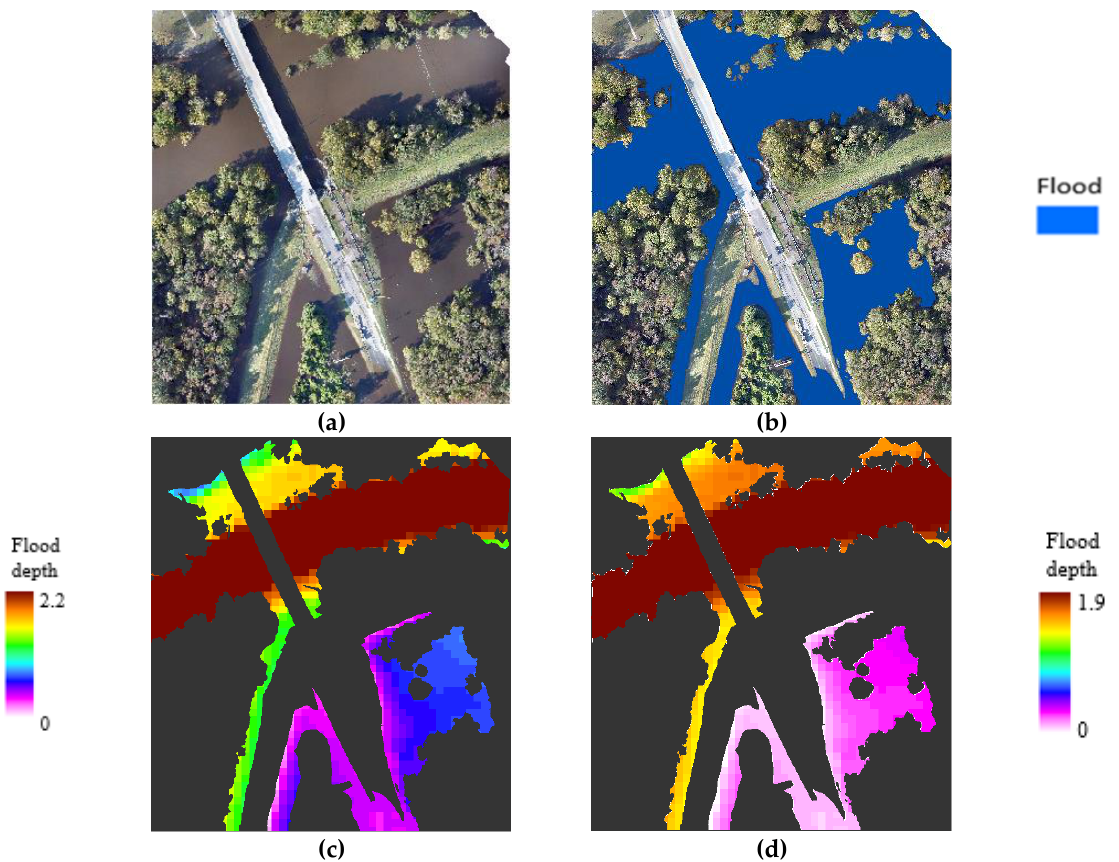
Figure 7. Inundation depths results; ( a ) test image; ( b ) flood extent from CNN; ( c ) ID results for method 1; ( d ) ID results for method 2.